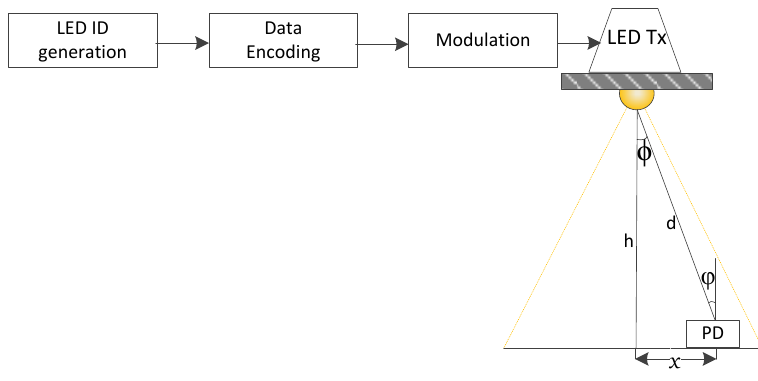
Figure 2. Optical positioning system with LED transmitter and photo-detector (PD)